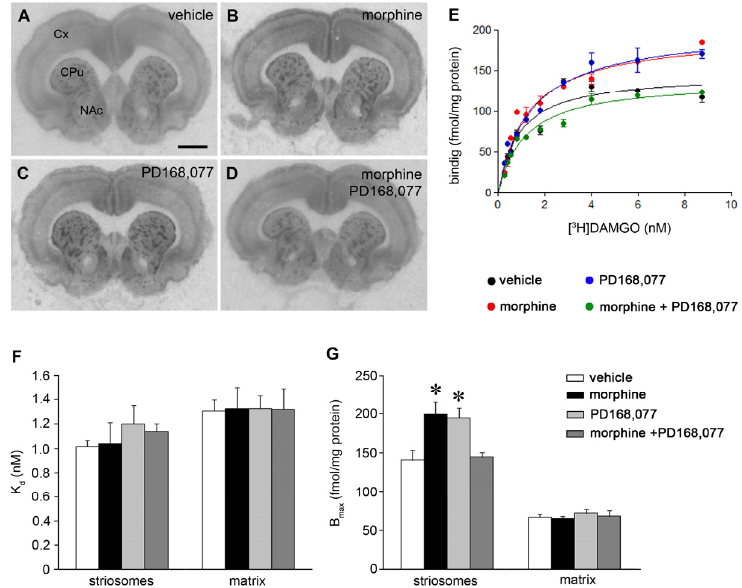
Figure 2. Co-administration of PD168,077 during continuous morphine treatment prevents the increase of [ 3 H]DAMGO binding sites induced by the opioid drug. ( A – D ) Representative autoradiograms from coronal brain sections at the CPu level of rats which received six days of continuous treatment with vehicle ( A ), morphine (20 mg/kg/day) ( B ); PD168,077 (1 mg/kg/day) ( C ) and morphine + PD168,077 ( D ); Abbreviations: Cx, cortex; CPu, caudate putamen; NAc, nucleus accumbens. Scale bar is 2 mm. ( E ) Saturation curves of [ 3 H]DAMGO binding in the striosomes; ( F , G ) Effect of drug treatments on K values (mean ± SEM; n = 6) of [ 3 H]DAMGO binding in the striosomes and matrix compartment of the rat CPu. * p < 0.05 vs. control and morphine + PD168,077 (one-way ANOVA followed by post hoc Bonferroni t